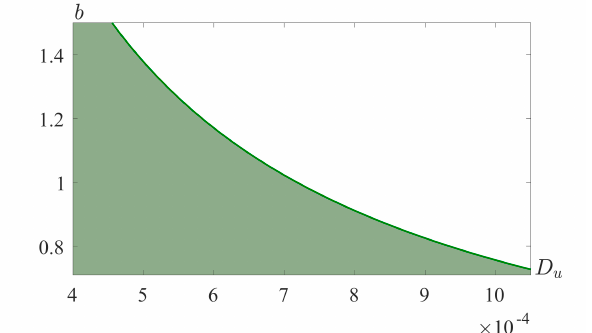
Figure 1. Bifurcation diagram of Systems (1), (2) with a = d = e = 0.5, c = 1, D v = 0.02, and ε = 0. The highlighted domain is the Turing instability zone.